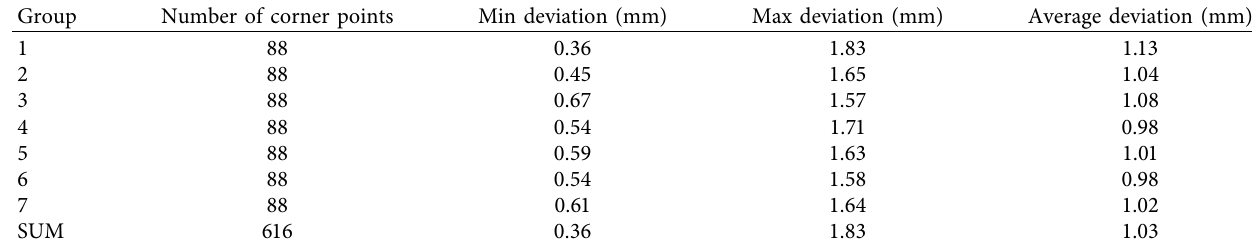
Table 4: Positioning